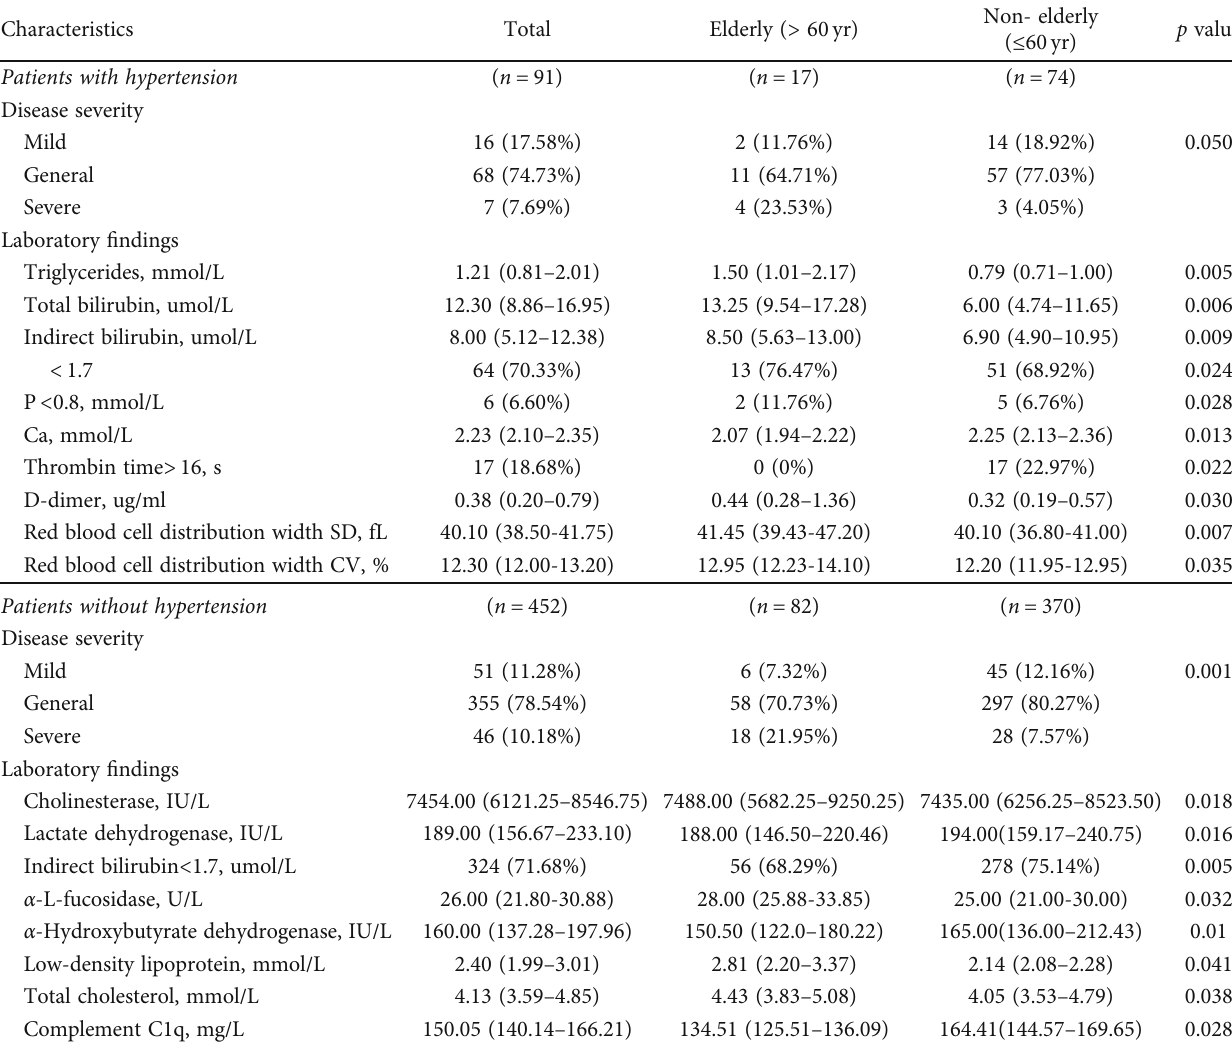
Table 2: Clinical characteristics and laboratory fi ndings in di ff erent age of hypertensive and non-hypertensive COVID-19 patients.